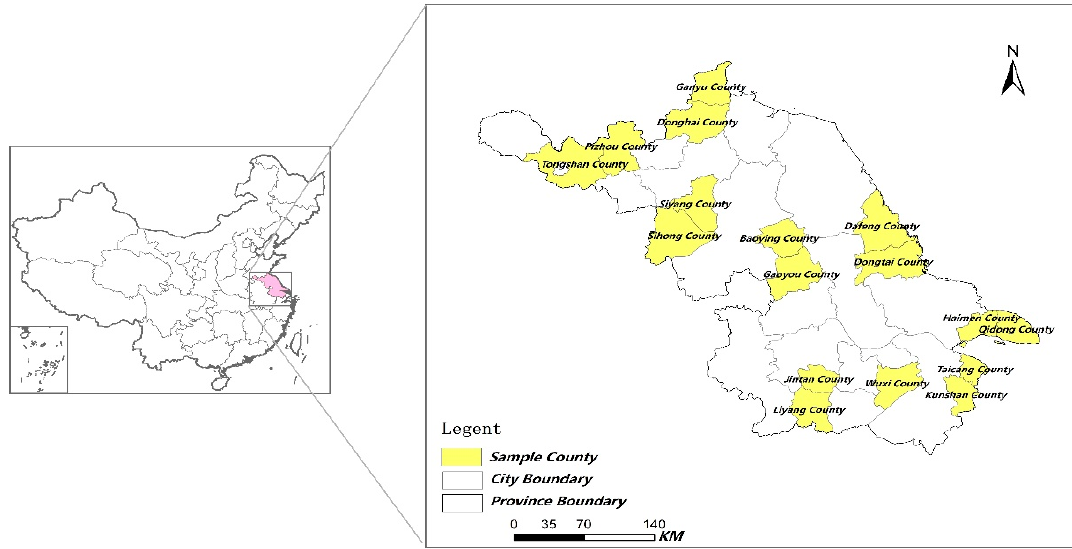
Figure 1. Location of Jiangsu Province and the study area.